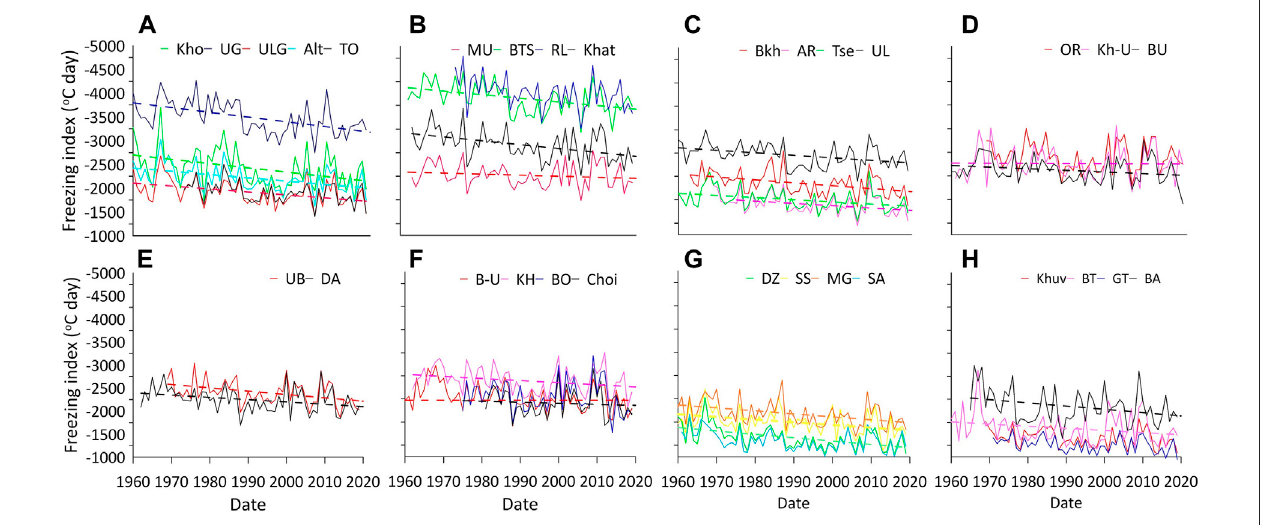
FIGURE 3 | Freezing index for 30 meteorological stations: (A) Altai mountains, (B) Khuvsgul Mountains, (C) Khangai mountains, (D) Orkhon and Selenge river valleys, (E) Khentii mountains, (F) Dornod steppe, (G) Gobi zone, and (H) Desert zone, respectively. The dashed lines show the linear trends, with colors matching the time series.